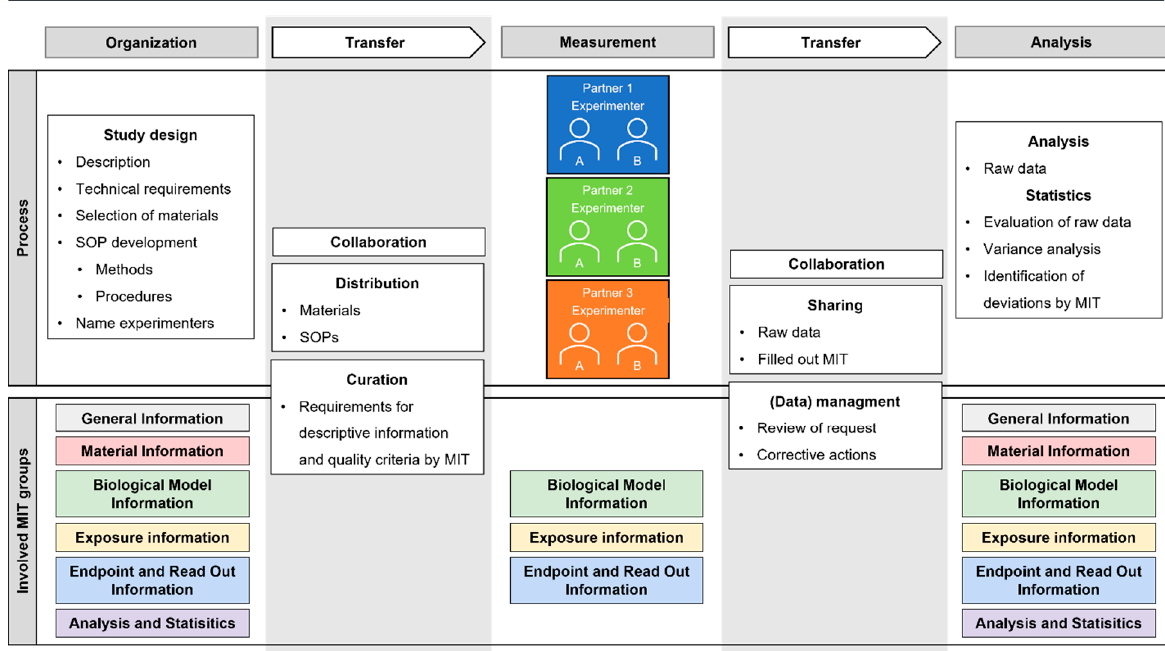
Figure 10. Evaluation process of the MIT by round-robin test. The planning and implementation of the round-robin test could be separated into organization, measurement, and analysis. The connective interfaces are transfer areas with collaboration processes including distribution, curation, sharing, and (data) management.